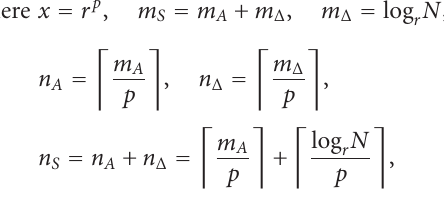
Figure 7: Accumulator of the MAC